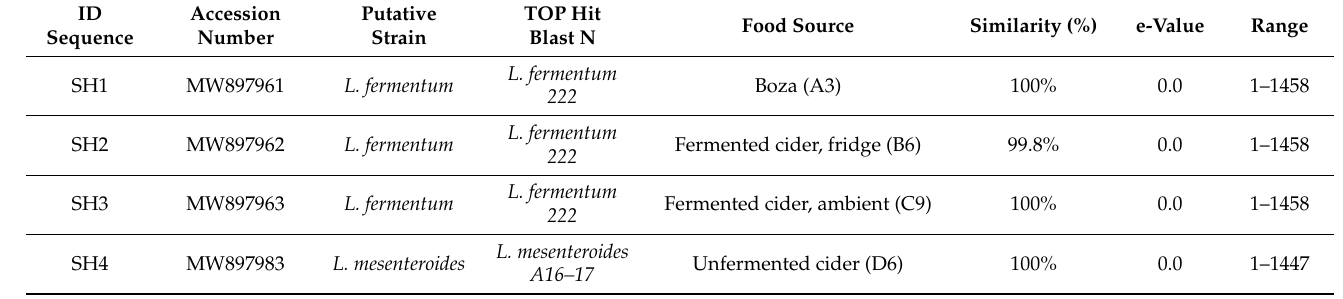
Table 1. Alignment of partial 16S rRNA sequencing of LAB under consideration with the sequence of NCBI database.